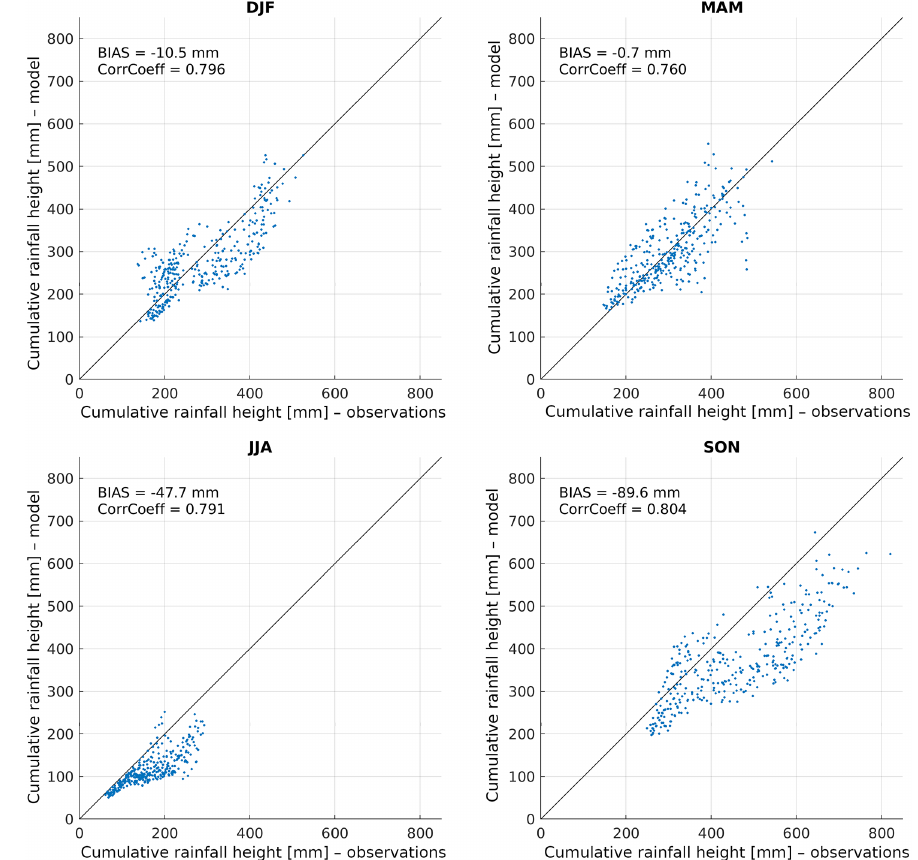
Figure 4. Scatter plots of seasonal precipitation built using data on EXPRESS-Hydro spatial resolution (pixel to pixel comparison). The X axis reports observed interpolated rainfall, and the Y axis reports EXPRESS-Hydro estimation.